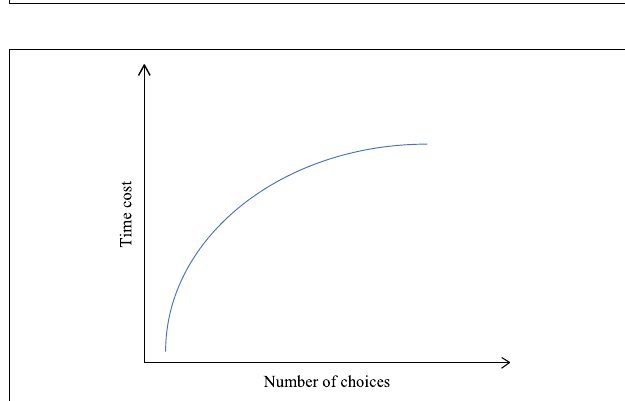
FIGURE 1 | Schematic diagram of the relationship between memory clarity and memory volume.